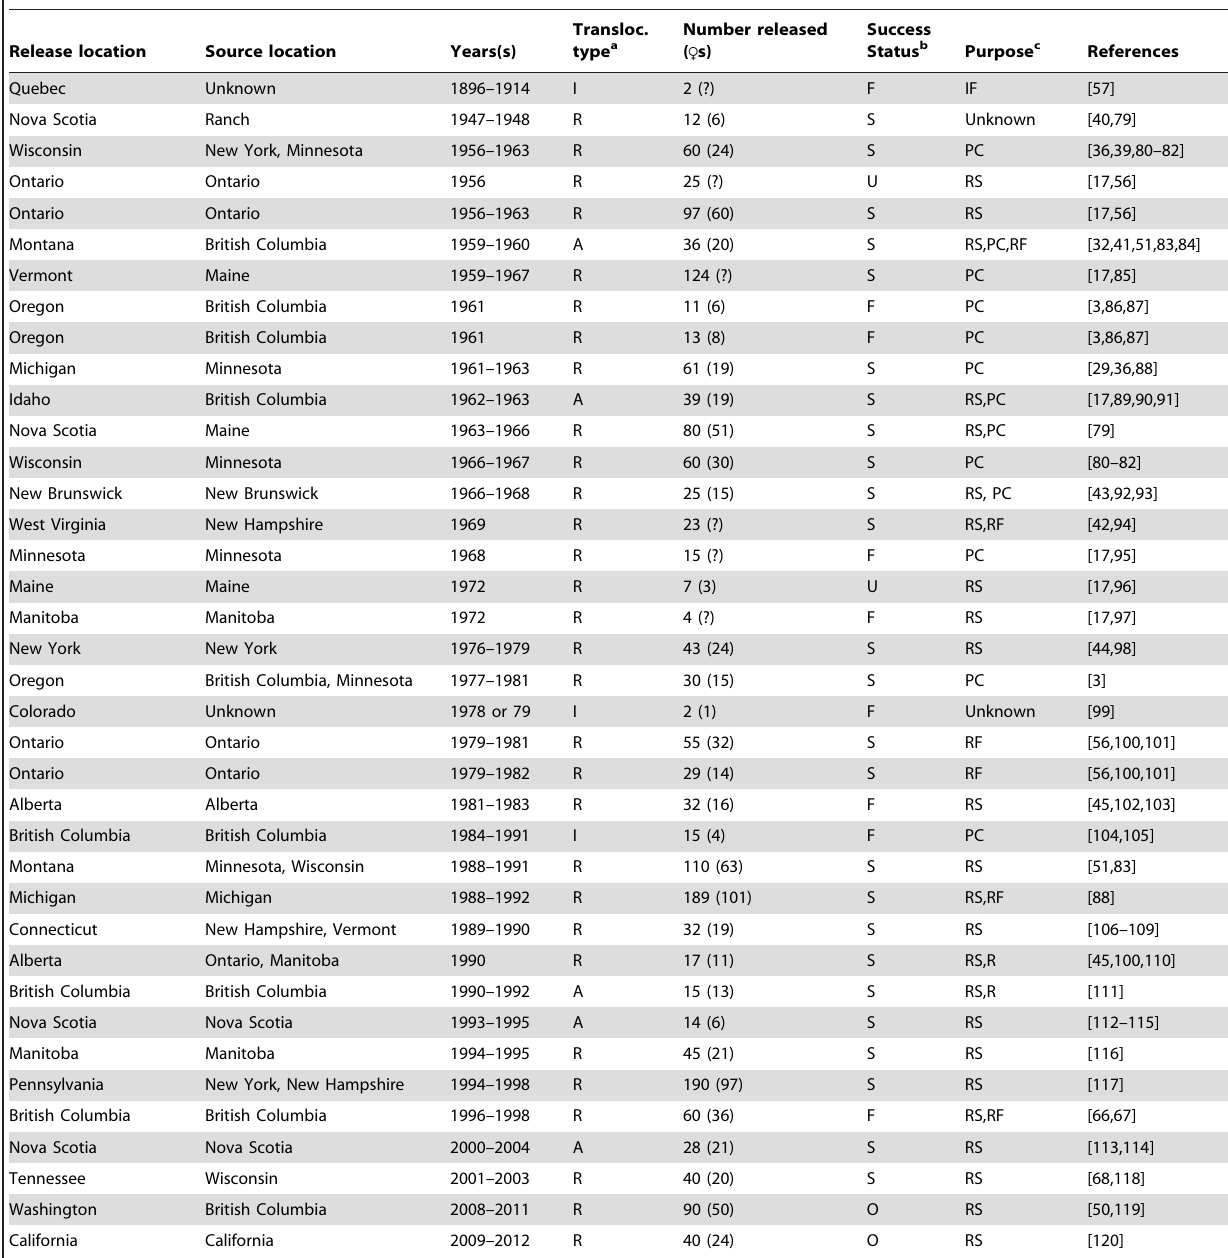
Table 5. Summary of data for 38 fisher translocations, 1896–2010, listed